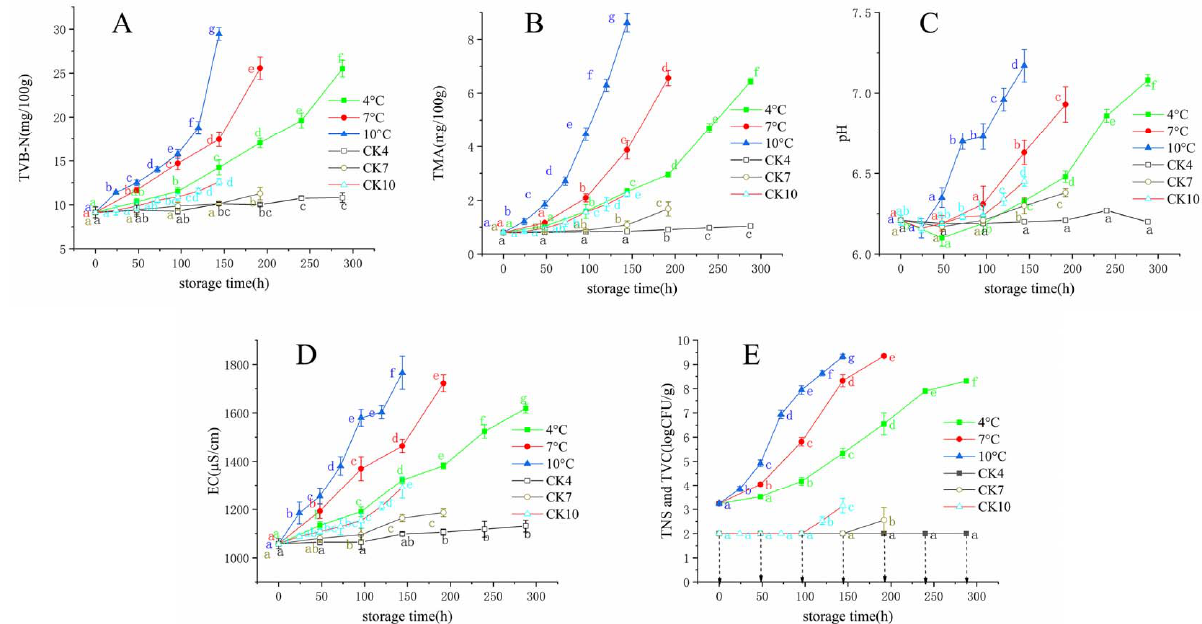
Figure 1. Changes in total volatile base nitrogen (TVB-N) ( A ), trimethylamine (TMA) ( B ), pH ( C ), Electrical conductivity (EC) ( D ), and total number of S. putrefaciens (TNS) of inoculation groups and total viable count (TVC) of control check (CK) groups ( E ) in bigeye tuna stored at different temperatures (each point is the mean value of three determinations). CK4, CK7, and CK10 are CK groups stored at 4, 7, and 10 ◦ C. a–g in the same column with different superscripts are significantly different ( p < 0.05). The arrow indicates that the viable count was below 2.0 log